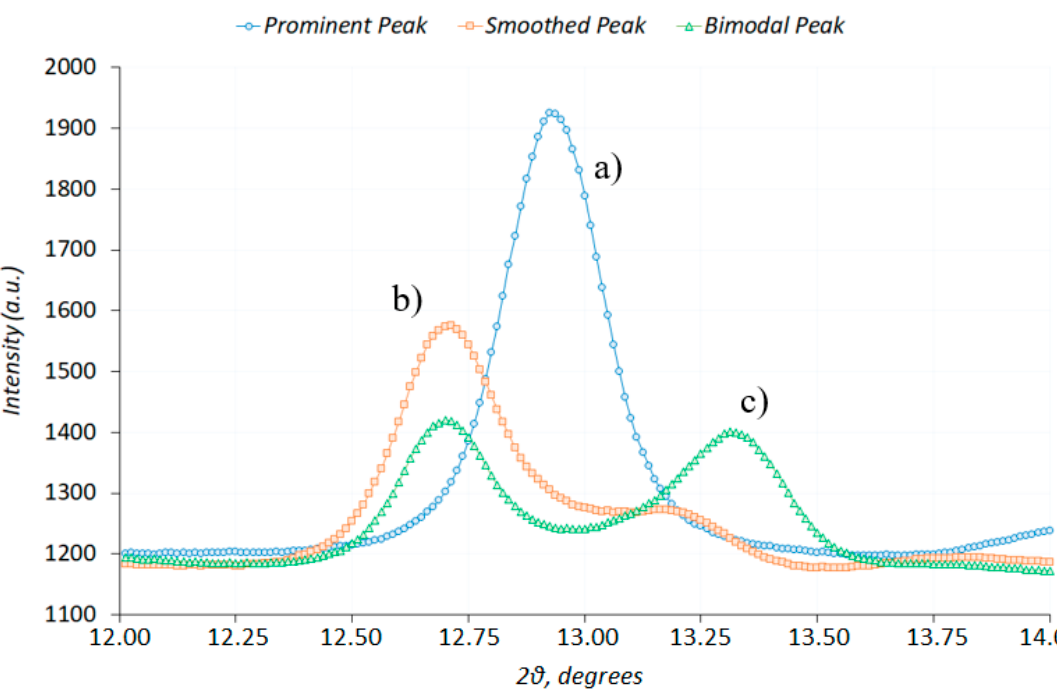
Figure 8. The evaluation of di ff raction peak centres for ( a ) single; ( b ) shouldered; and ( c ) double peaks [18].